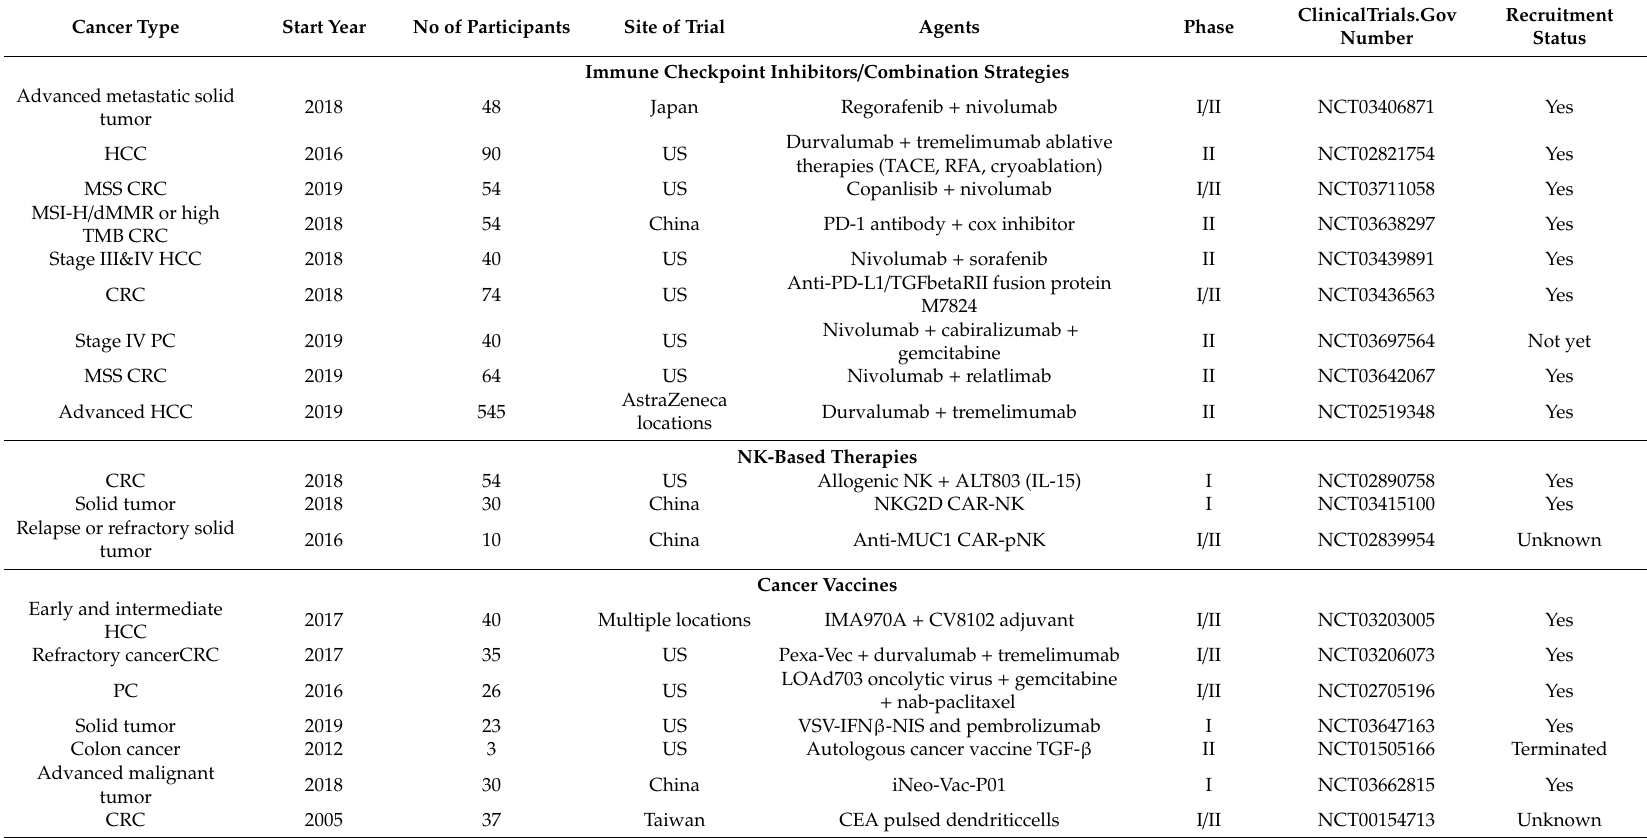
Table 3. Clinical trials of other immunotherapies in GI